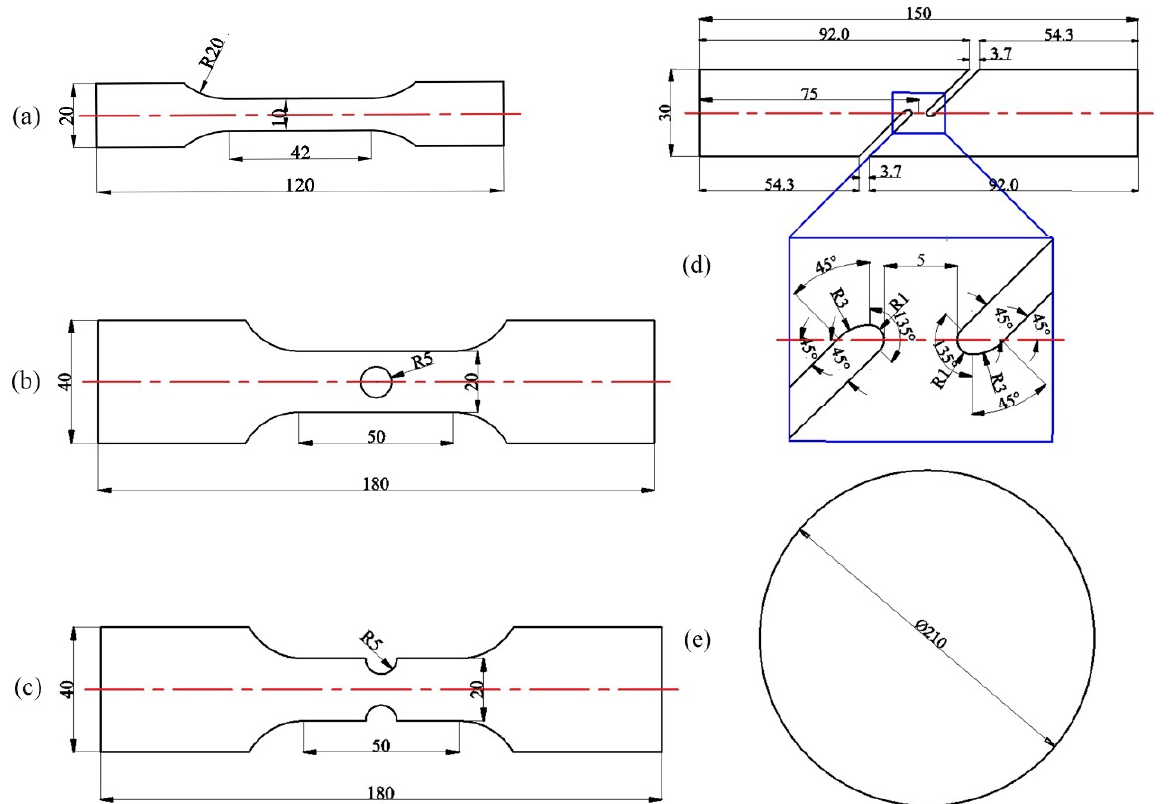
Figure 3. Geometrical dimension of five tensile specimens: ( a ) dogbone; ( b ) central hole; ( c ) notched (R5); ( d ) in-plane shear; and ( e ) Nakajima (Units: mm).